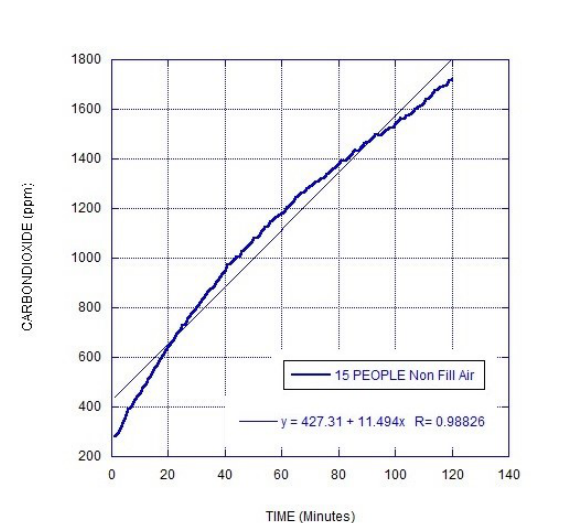
Figure 1. Increasing rates of CO 2 in the experimental room